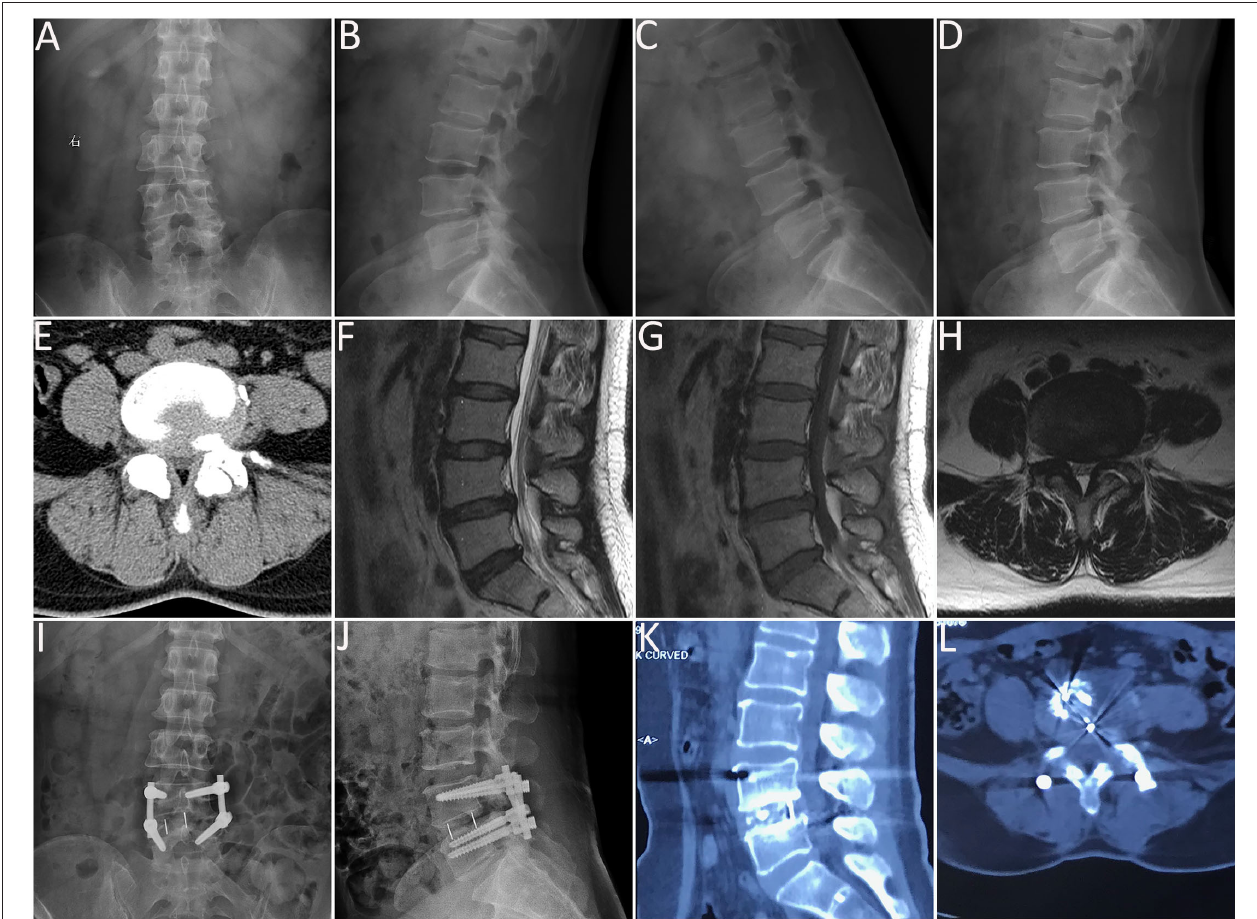
FIGURE 3 | Minimally invasive transforaminal lumbar interbody fusion (MI-TLIF) performed on a 48-year-old female patient diagnosed with L4-L5 lumbar spinal stenosis with degenerative spondylolisthesis. (A,B) preoperative anteroposterior and lateral plain radiographs; (C,D) preoperative flexion and extension radiographs; (E) preoperative computed tomography (CT) scans; (F–H) preoperative magnetic resonance imaging (MRI) scans; (I,J) anteroposterior and lateral plain radiographs 3 days after the surgery; (K,L) CT scans 12 months after the